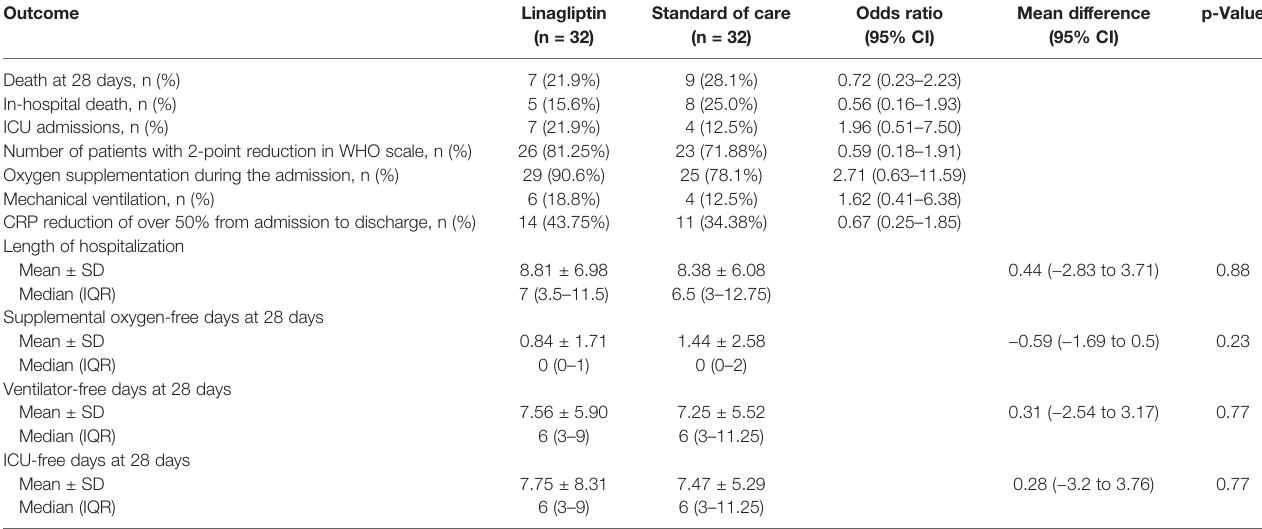
TABLE 2 | Outcomes in the intention-to-treat population. Outcome